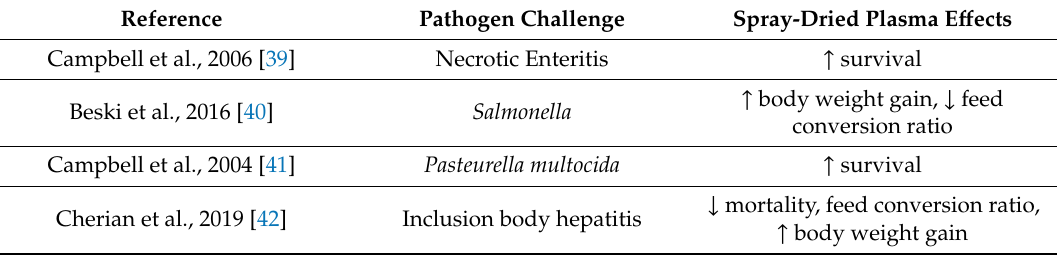
Table 2. Summary of spray-dried plasma e ff ects during pathogen challenge in